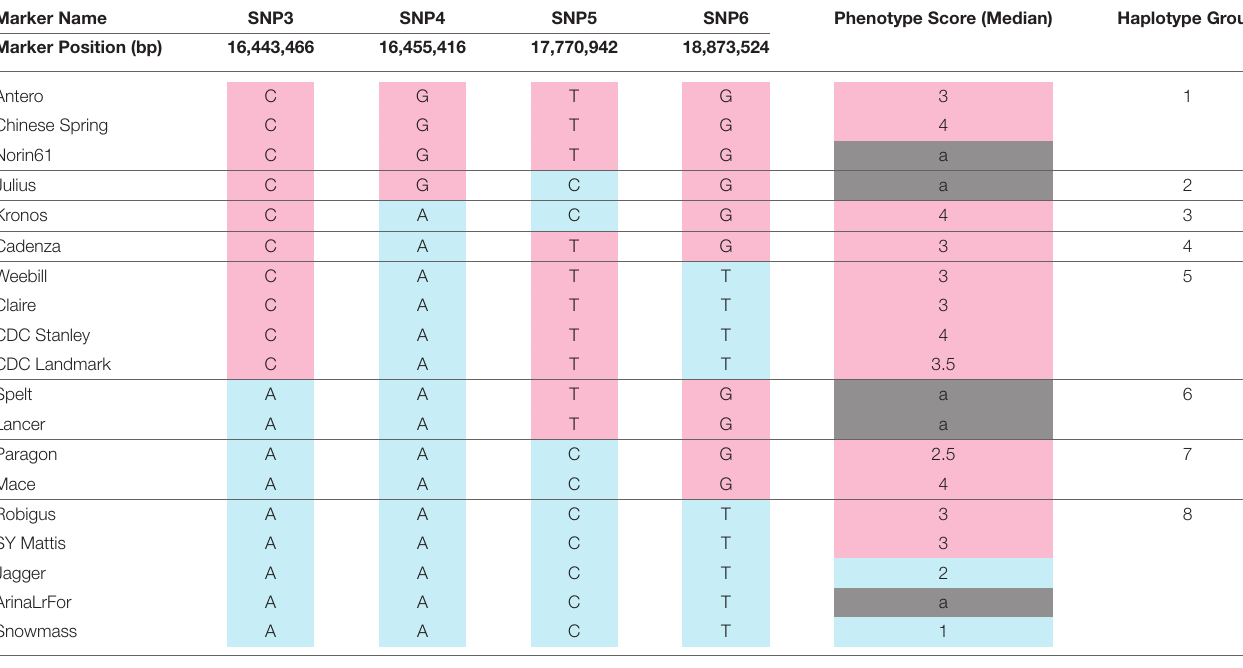
TABLE 1 | Haplotype analysis of Wsm2 in 19 wheat